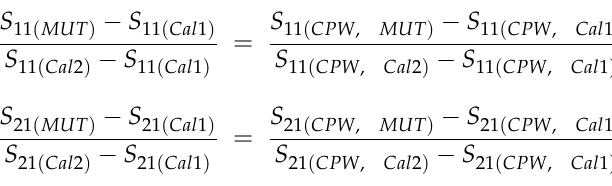
Figure 8. The overall simulation results for the particle signal profiling of the system responses, at different positions relative to the cross-section of the sensing CPW structure, to mimic the process of particle passing through the sensor. ( a ) the magnitude and ( b ) the phase of transmission signal S 21 .